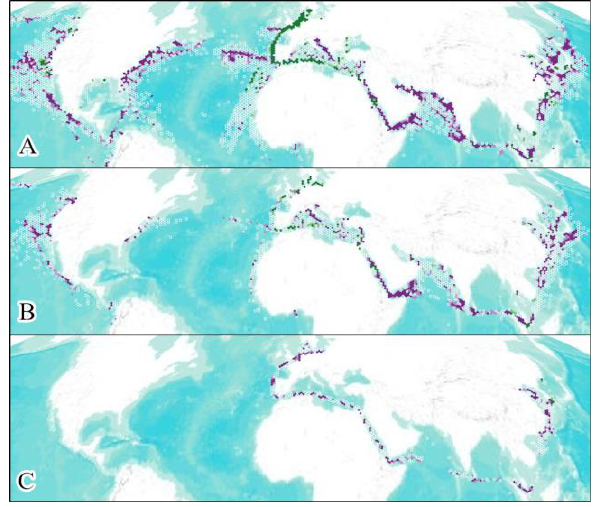
Figure 14 Trend analysis on counted AIS’ positions over all bin locations, for TEU classes. (Basemap sources: Esri, USGS, NOAA).